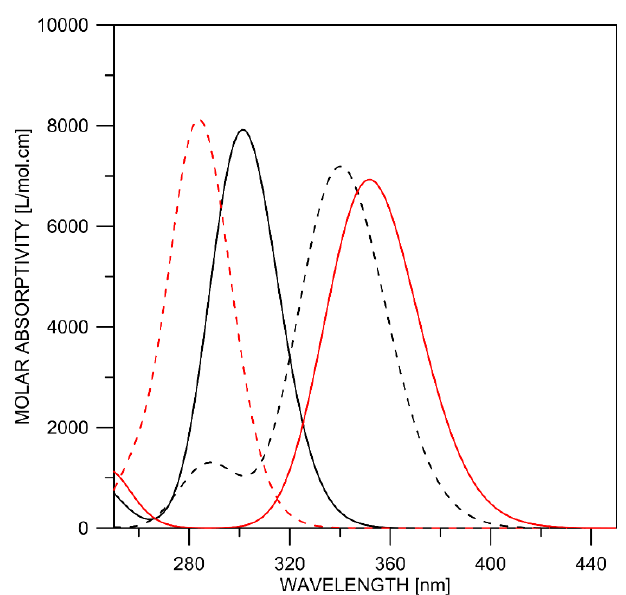
Figure 2. Absorption spectra of favipiravir in acetonitrile/water mixtures with stepwise decrease of the acetonitrile content: (1) 100% acetonitrile (0% water, black solid line), (2) 80% acetonitrile (20% water, green solid line), (3) 60% acetonitrile (40% water, magenta solid line), (4) 40% acetonitrile (60% water, blue solid line), (5) 20% acetonitrile (80% water, red solid line) and (6) calculated spec- trum of the keto form (black dash line). The calculated spectrum of the pure enol form (red dash line) fully overlaps with curve (1).